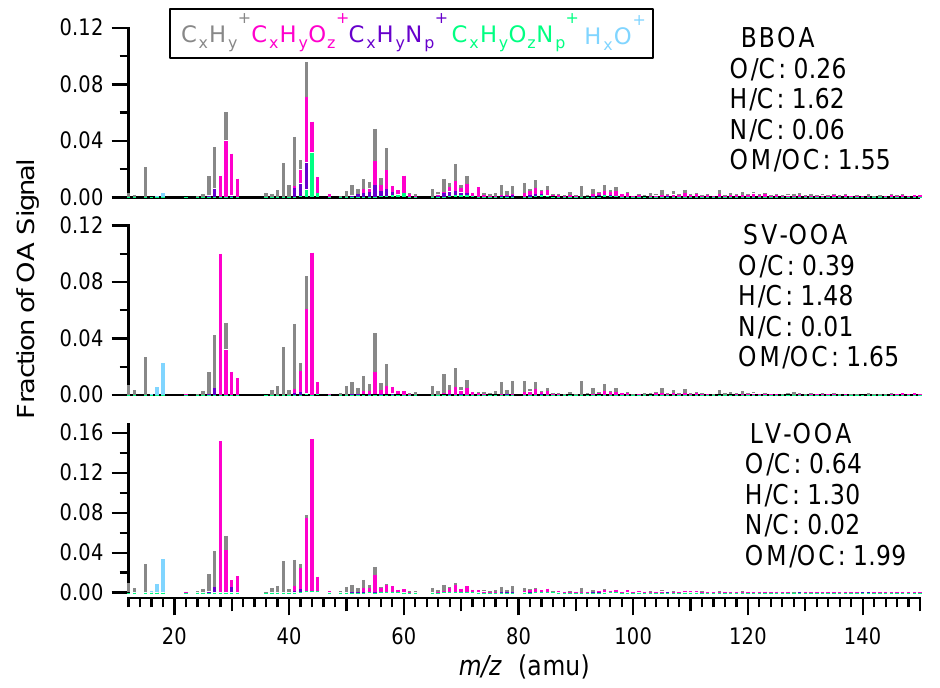
Fig. 5. The MS profiles of the three OA components identified by PMF in this study.